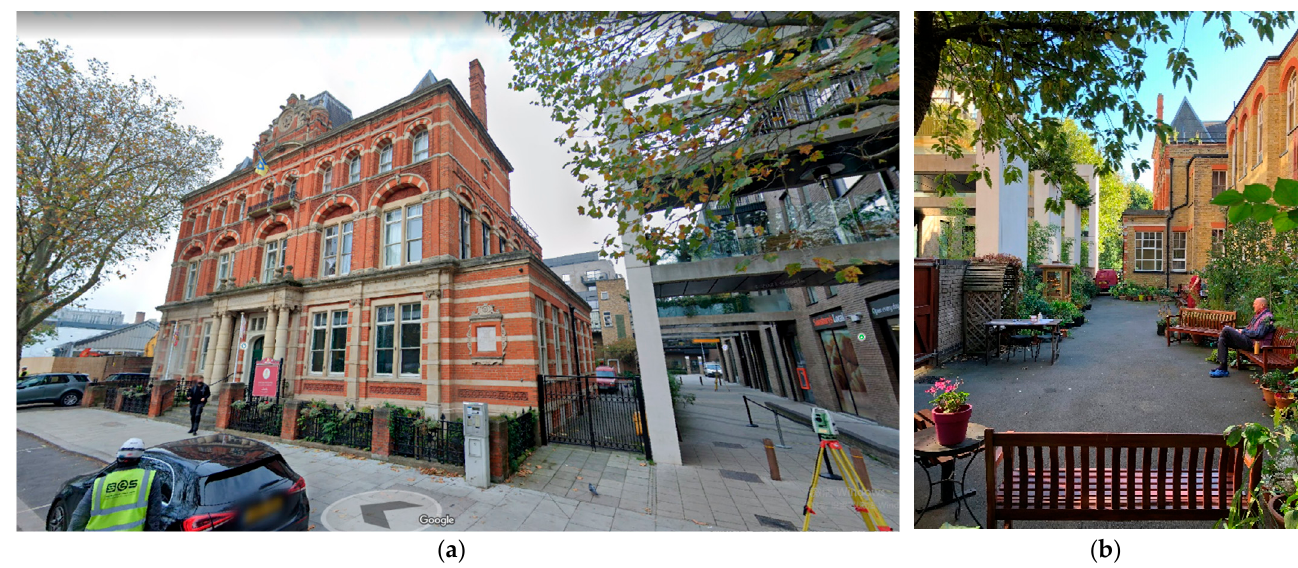
Figure 5. ( a ) Street view of Kagyu Samye Dzong London (source: Google Map); ( b ) garden of Kagyu Samye Dzong London (photo by primary author).